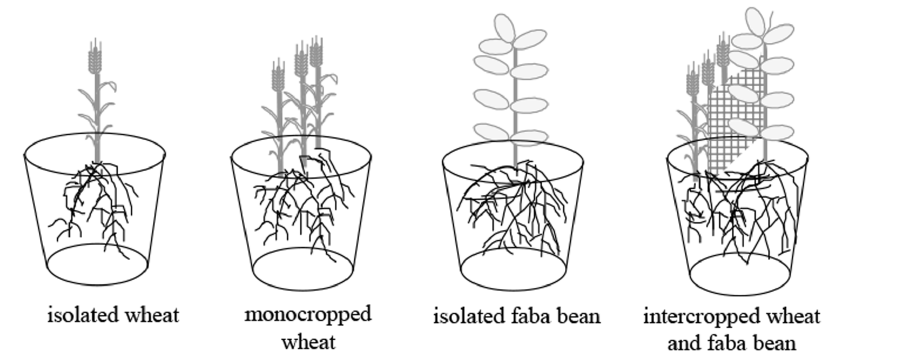
Fig. 1. Schematic representation of different plant